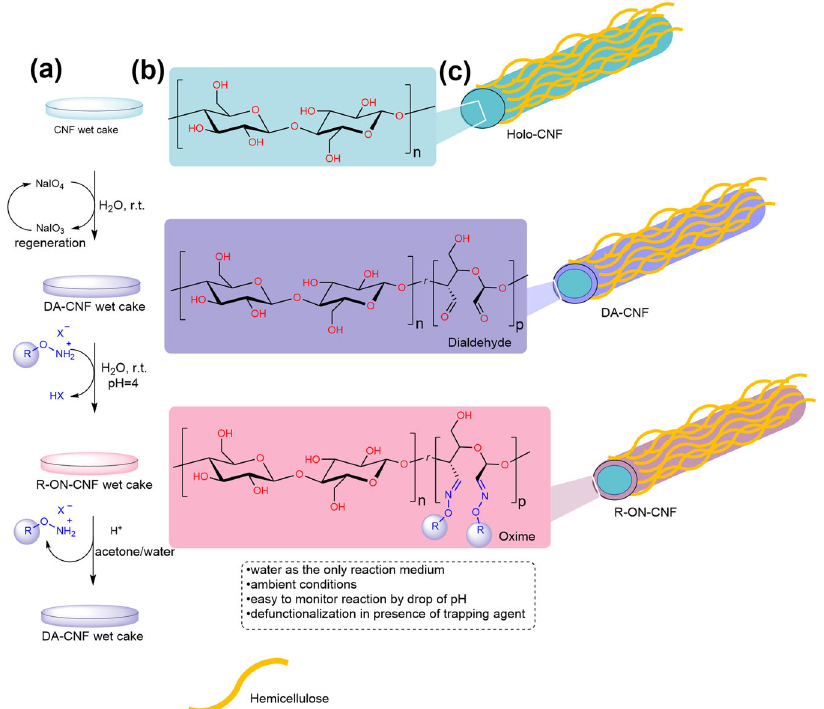
Fig. 1 | Schematic representation of the developed method. a Oxidation and functionalization of Holo-CNF 5 in water. b Schematic representation of molecular structure of pristine Holo-CNF, DA-CNF, and R-ON-CNF with regions of pristine cellulose and modi fi ed cellulose chains. c Schematic representation of